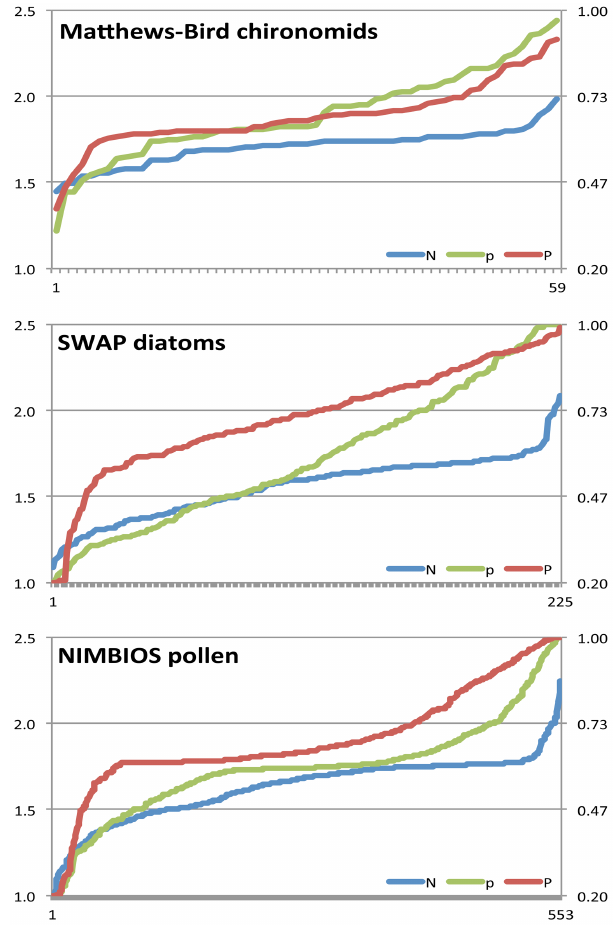
Figure 1. Probability-weighted SRC parameters N k (left-hand axis), p k (left-hand axis) and P k (right-hand axis) are plotted for all taxa. Three training sets are considered: chironomid-based tem- perature (Matthews-Bird et al., 2016), diatom-based pH (Stevenson et al., 1991), and pollen-based temperature (Bush et al., 2017). The x axes represent the distinct taxa in the training sets (59 chirono- mid taxa, 225 diatom taxa, and 553 pollen taxa). For each of the three SRC parameters, probability-weighted values are derived for each taxon. These are ordered by increasing value and are plotted sequentially. Horizontal grid lines represent the discrete values al- lowed within individual